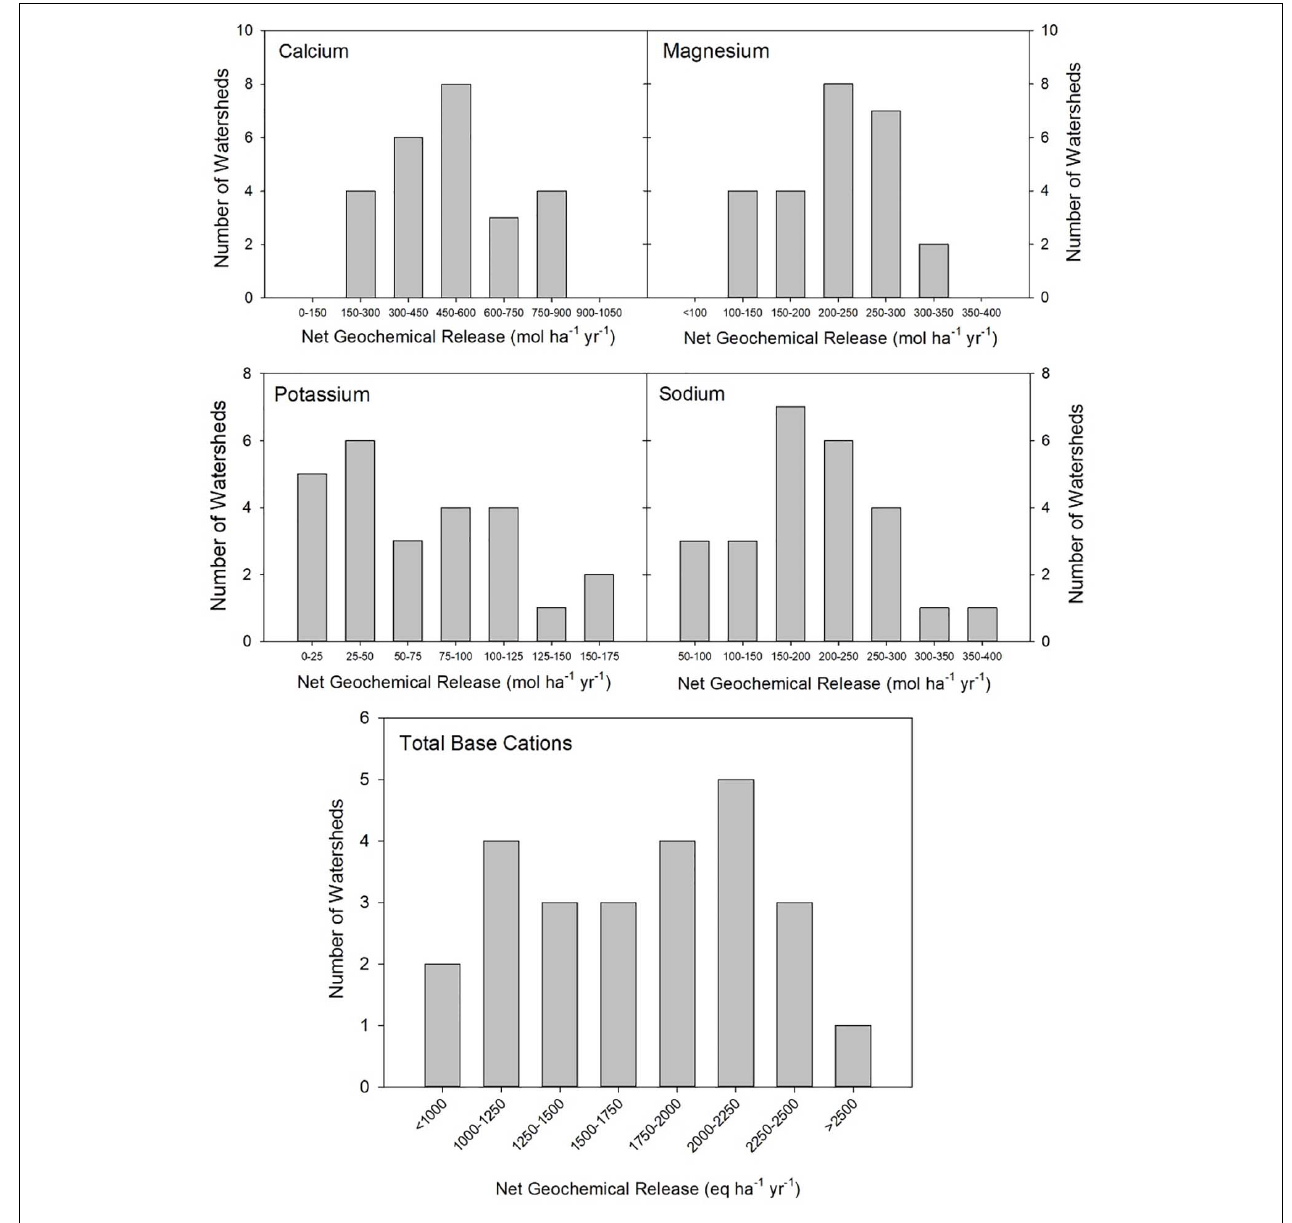
FIGURE 3 | Histograms of net geochemical release rates using the mass-balance